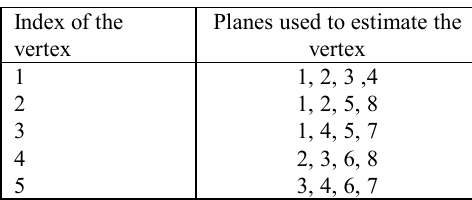
Table 7. Map of the index of each vertex and the planes used for its estimation for Scenario 2.